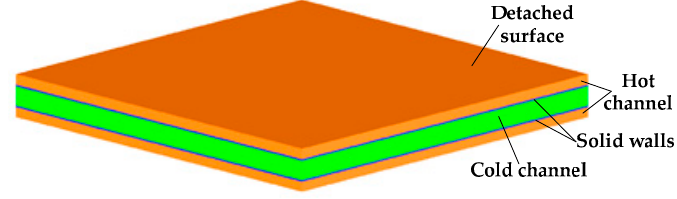
Figure1. Computational domain of plate heat exchanger. Figure 1. Computational domain of plate heat